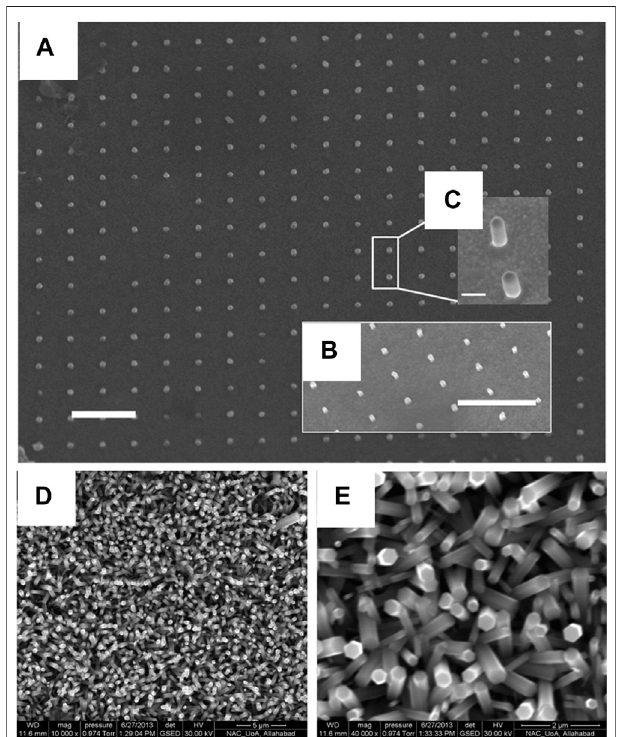
FIGURE 1 | SEM images of patterned nanorods on silicon substrates. Panel (A) isaviewfromthetop,whileinsets (B) and (C) are60 ° -tiltedviews.The scale bars indicate 1 μ m for (A) and (B) , and 200 nm for inset (C) (Hassanpour et al., 2017)., SEM image of ZnO nanorods with (D) lower magni fi cation (10000 x) and (E) higher magni fi cation (40000 x). (Srivastava et al.,